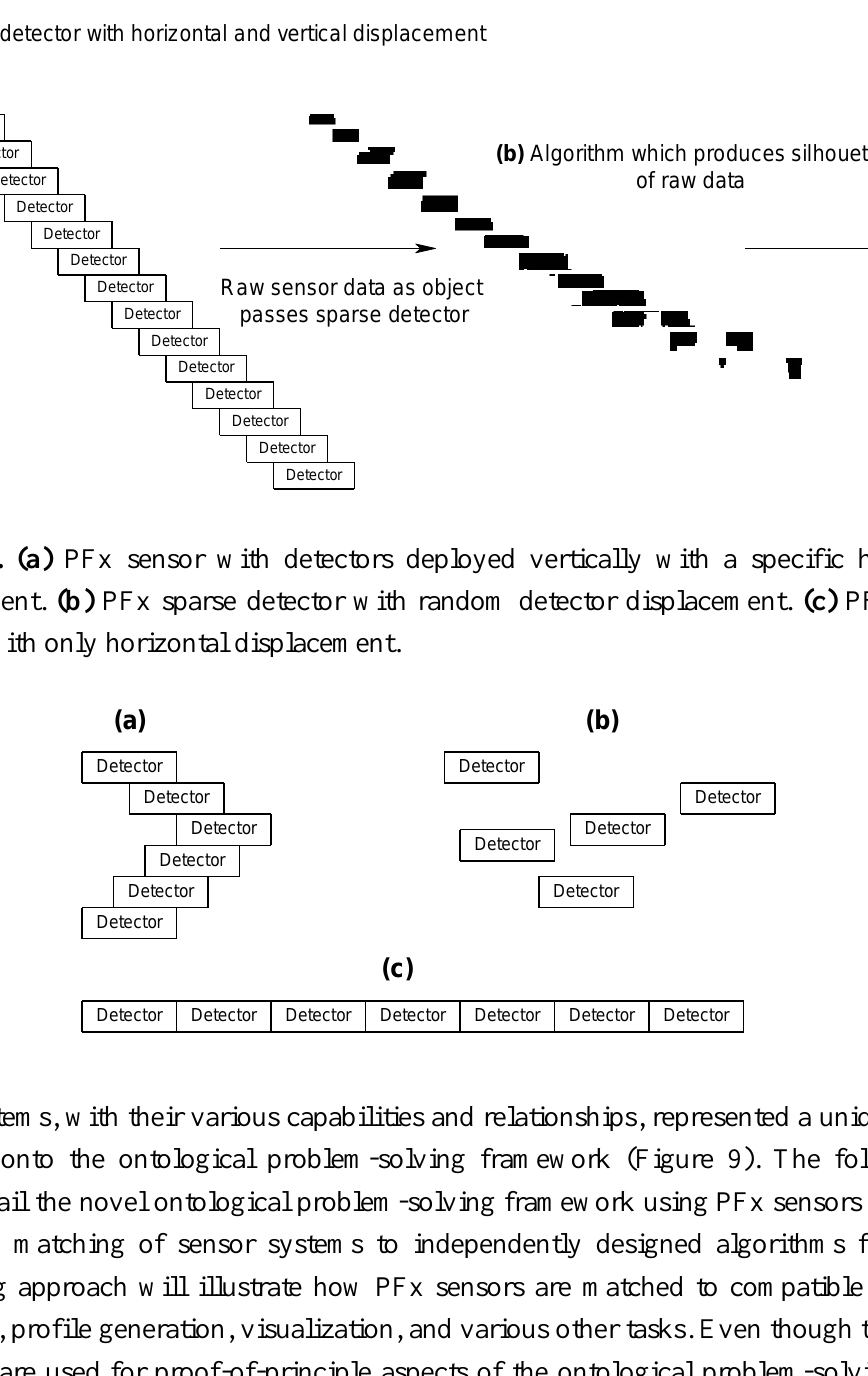
Figure 7. (a) PFx sensor with detectors deployed vertically with a horizontal displacement. (b) PFx raw data formatted by an algorithm as a profile.